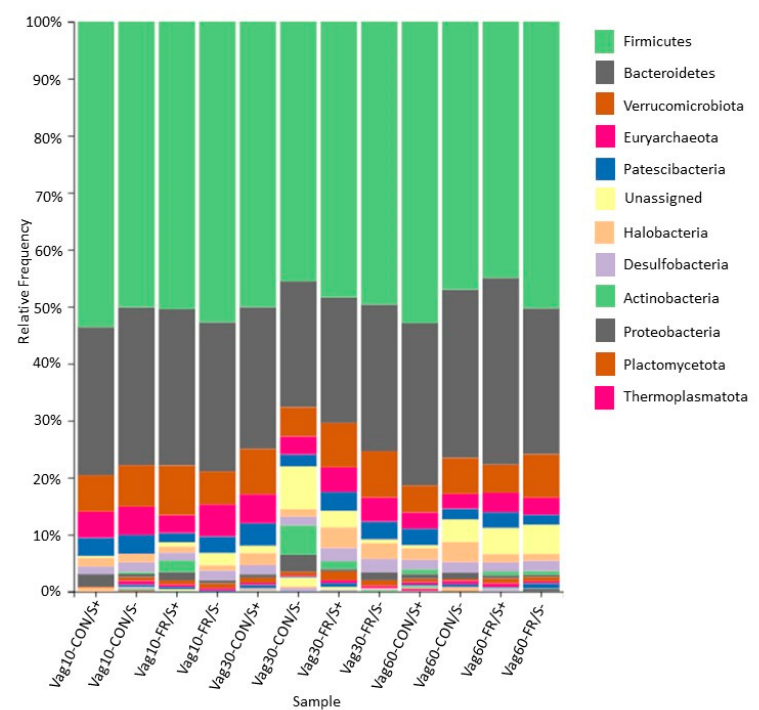
Figure 2. Qualitative phyla-level taxonomy plot of the microbiome of feed by mineral treatment groups for the vagina. The most relatively abundant taxa across all treatments and tissue types were Firmicutes , Bacteroidetes , and Verrucomicrobiota . Microbiome timepoints were taken at Vag60 = 60 days prior to parturition; Vag30 = 30 days prior to parturition; and Vag10 = 10 days prior to parturition. Treatments include CON/S+ = control diet with mineral supplementation; CON/S − = control diet without mineral supplementation; FR/S+ = 70% feed intake restricted diet with mineral supplementation; and FR/S- = 70% feed intake restricted diet without mineral supplementation.